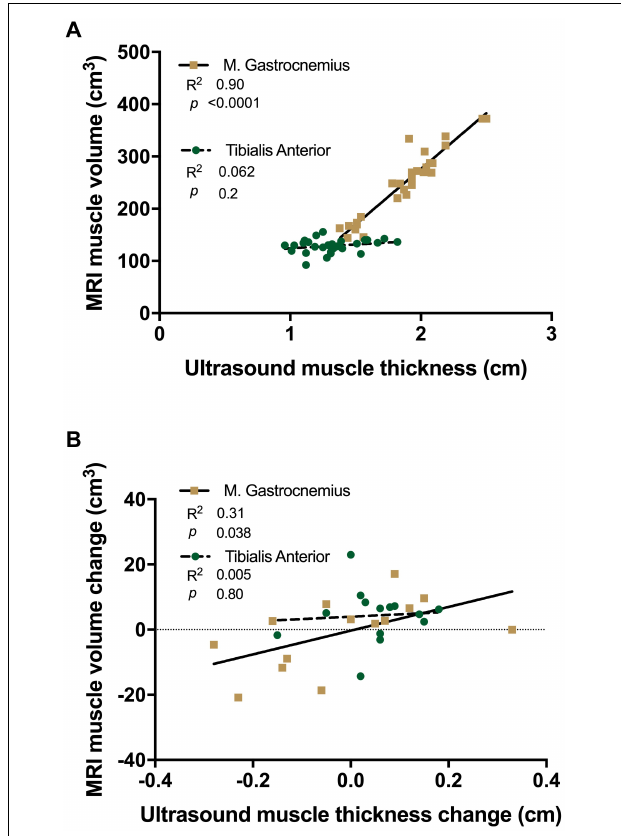
FIGURE 6 | Linear regression analysis of ultrasound derived muscle thickness vs. MRI muscle volume (A) and changes with 15 day unilateral leg immobilisation (B) in tibialis anterior (TA, green) and medial gastrocnemius (MG,